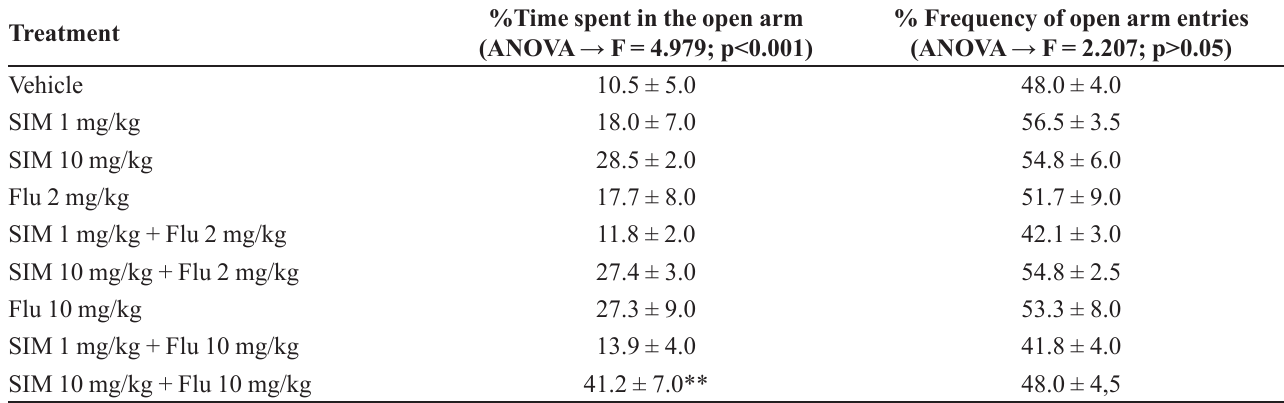
TABLE II – Behavioral responses of rats in the elevated plus-maze following sub-chronic simvastatin (SIM) treatment combined with fluoxetine (Flu) - percent time spent in the open arm and percent frequency of open arm entries. Values are expressed as the mean ± standard error of the mean; n = 8, **p<0.01. Statistically significant compared to the vehicle group (analysis of variance [ANOVA] followed by the Newman-Keuls